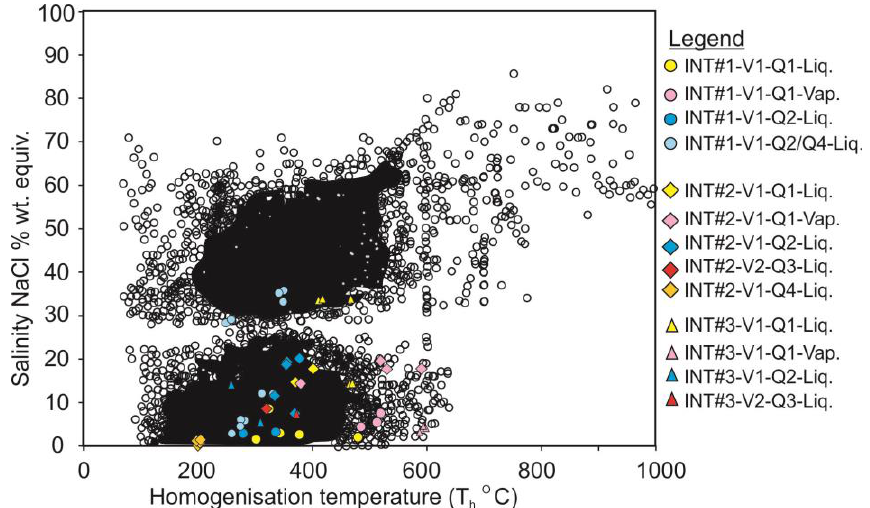
Figure 14. Homogenization temperature versus salinity of world porphyry copper deposits (from [33]) compared with Kışladağ data.